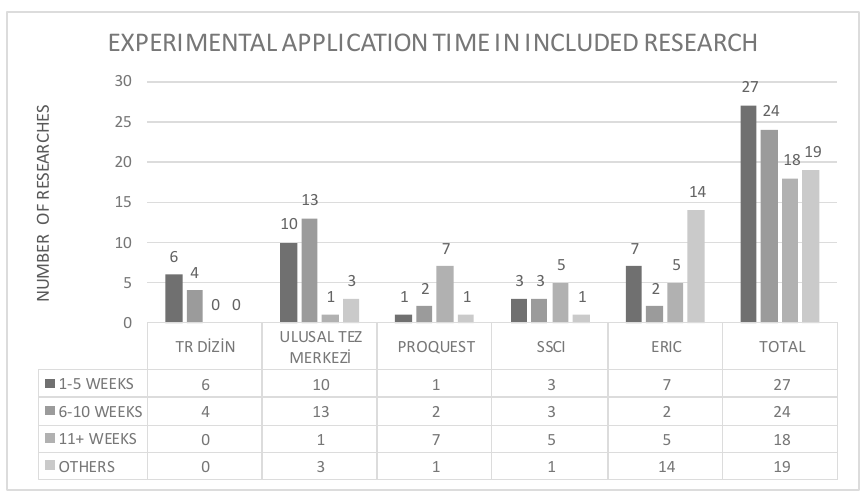
(cid:39)(cid:88)(cid:85)(cid:68)(cid:87)(cid:76)(cid:82)(cid:81)(cid:3)(cid:82)(cid:73)(cid:3)(cid:72)(cid:91)(cid:83)(cid:72)(cid:85)(cid:76)(cid:80)(cid:72)(cid:81)(cid:87)(cid:68)(cid:79)(cid:3)(cid:86)(cid:87)(cid:88)(cid:71)(cid:76)(cid:72)(cid:86)(cid:17)(cid:3)